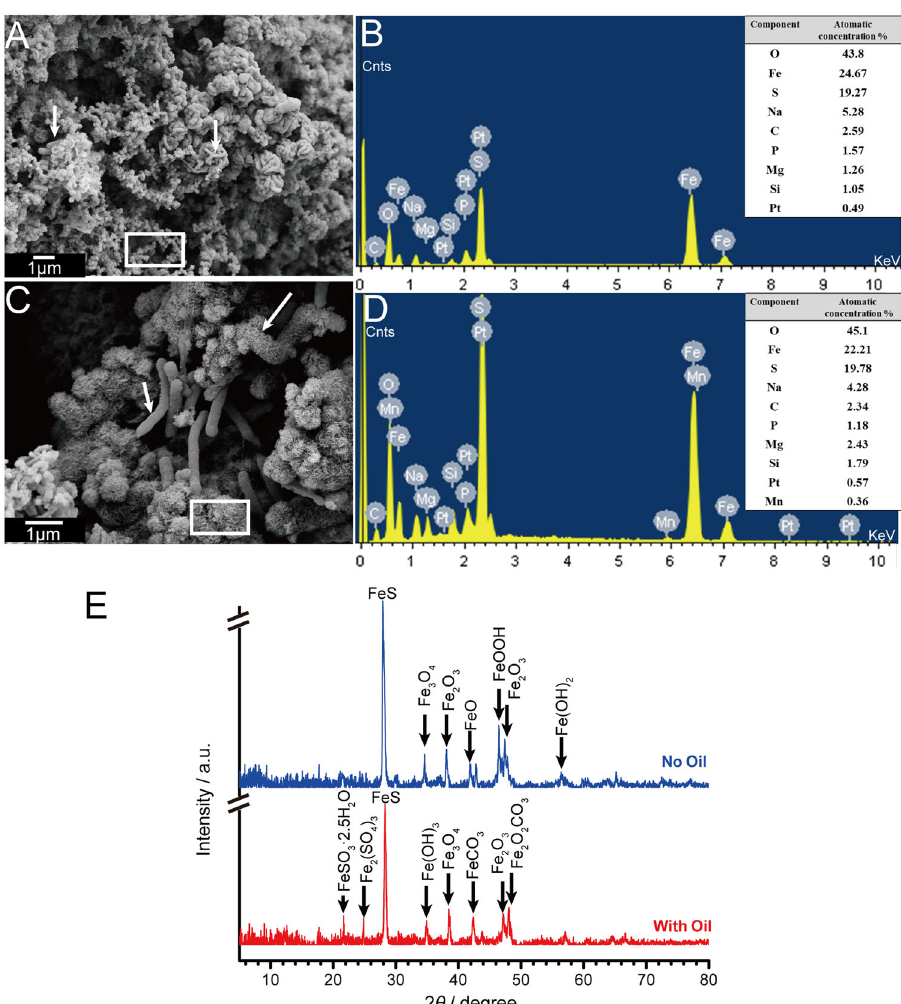
Fig. 4 Corrosion mineralogy of steel in seawater simulators after 85 days of exposure to seawater with/without crude oil. SEM images with high magni fi cation view of corrosion products and microbes with ( A ) and without ( C ) crude oil. EDS spectra of typical corrosion products with ( B ) and without ( D ) crude oil. White rectangles represent the corresponding areas for EDS analysis. White arrows represent attached microbes. E XRD analysis of representative corrosion products. Indicative diffraction peaks for key Fe-corrosion phases were noted. “ With Oil ” : With crude oil amendment; “ No Oil ” : Without crude